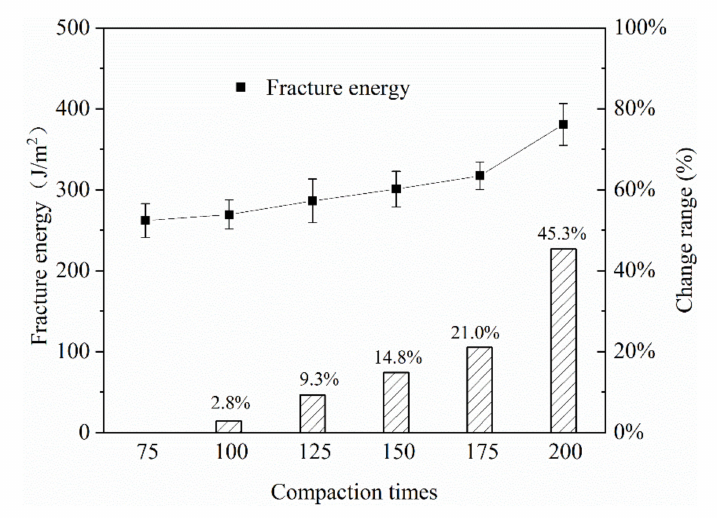
Figure 15. The impact of compaction times on the fracture energy of the